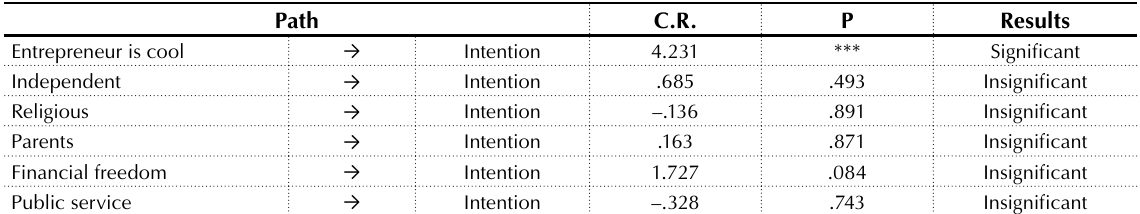
Table 4. Structural equation model of the theoretical framework